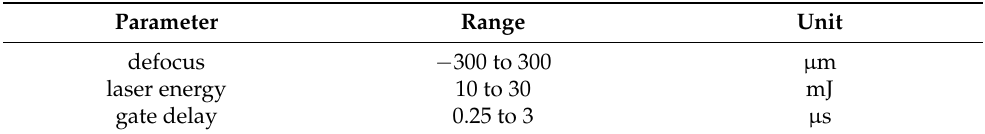
Table 2. Defocus, laser energy, and gate delay were changed in given ranges throughout the opti- mization procedure. Parameter Range Unit defocus − 300 to 300 µ m laser energy 10 to 30 mJ gate delay 0.25 to